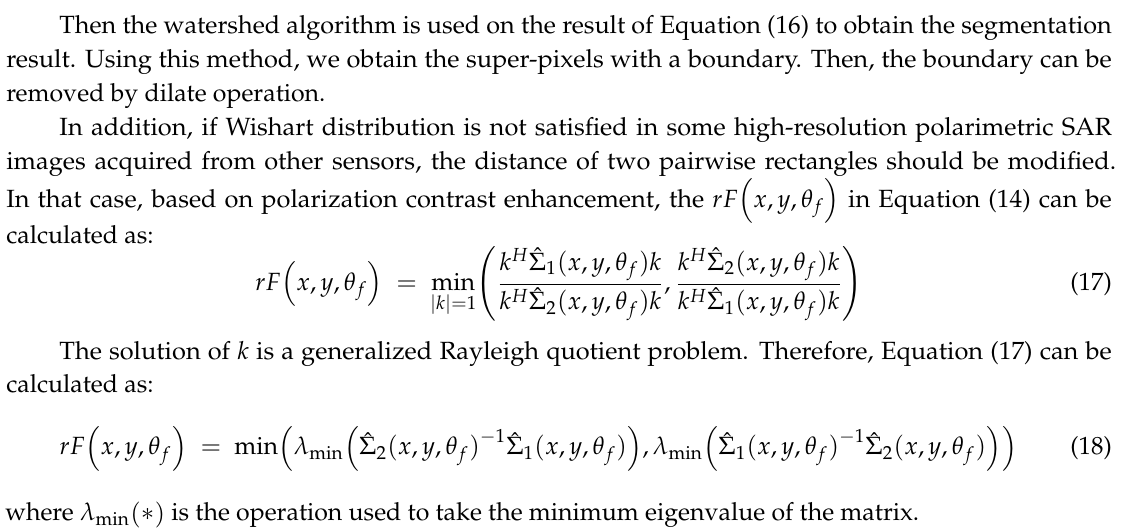
Figure 2. The majority vote process.